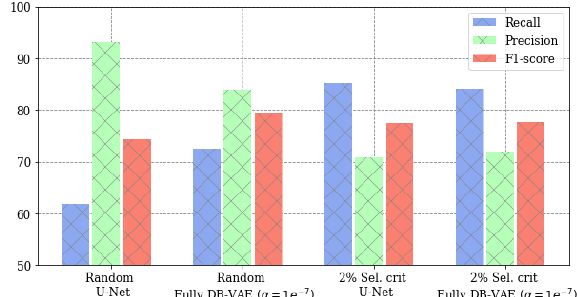
Figure 4. Classification metrics in [%], for the U-Net and Fully DB-VAE with α = 1 e − 7 , using random samples and the 2% selection